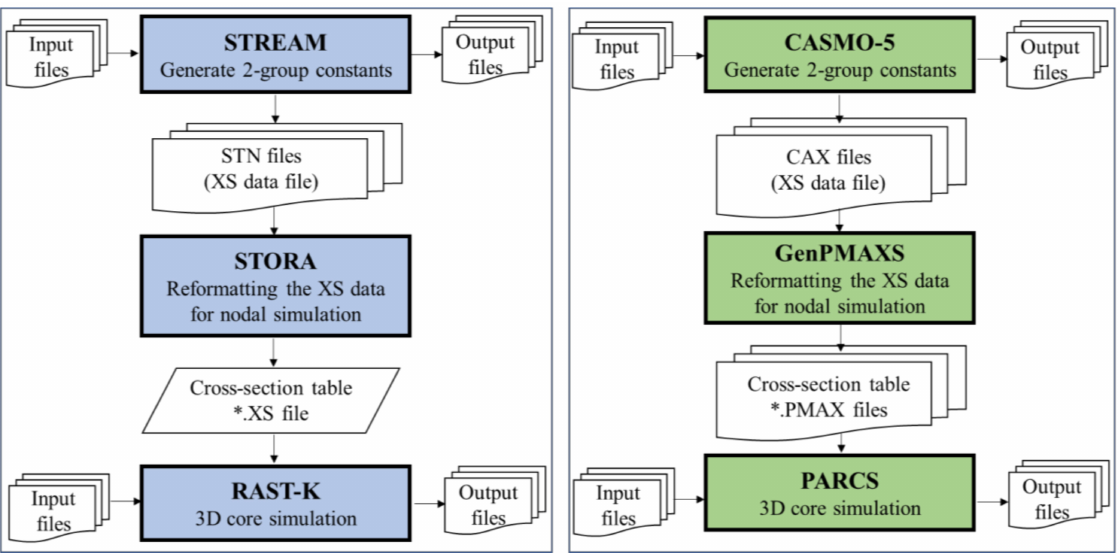
Figure 1. Flowchart of STREAM/RAST-K and CASMO-5/PARCS code